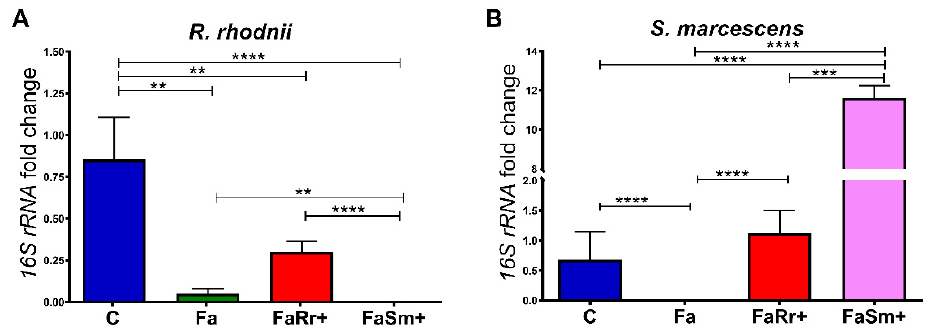
Figure 1. RT-qPCR determination of bacterial load in the anterior midgut of 5th instar nymphs of Rhodnius prolixus 7 days after feeding. The insects were previously treated with antibiotics as 4th instar nymphs and orally recolonized with Rhodococcus rhodnii or Serratia marcescens added to the blood meal of 5th instar nymphs. The antibiotic treatment consisted of ampicillin, penicillin, and hygromycin, with final concentrations of 150, 150, and 1 µ g/mL, respectively, of defibrinated rabbit blood meal, and the treatment with R. rhodnii or S. marcescens added to the blood meal was 10 4 and 10 3 /mL, respectively. Analysis of relative expression of 16S-rRNAs gene from ( A ) R. rhodnii and ( B ) S. marcescens by RT-qPCR. Treatments: control (C); insects treated with antibiotics on 4th instar only (Fa); R. rhodnii (FaRr+); S. marcescens (FaSm+). Each bar represents the mean of relative quantification (RQ) values of 2 experiments, each experiment with 2 pools of 5 insect tissues each, corresponding to 20 insects ( n = 4). The relative quantification by the ∆∆ Ct method was performed using the control group (insects fed with blood only) as the calibrator. All data were normalized to the R. prolixus 18S-rRNA. ∆∆ Ct values were analyzed by one-way ANOVA with the post-hoc Tukey test, ** p < 0.01; *** p < 0.001, **** p <